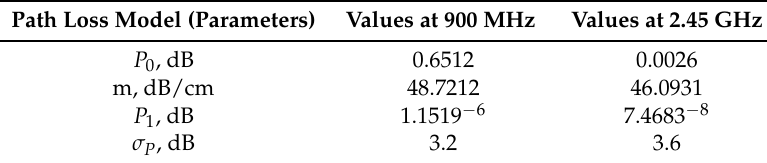
Table 6. Channel model for the narrow band ( i.e. , CM3-B).